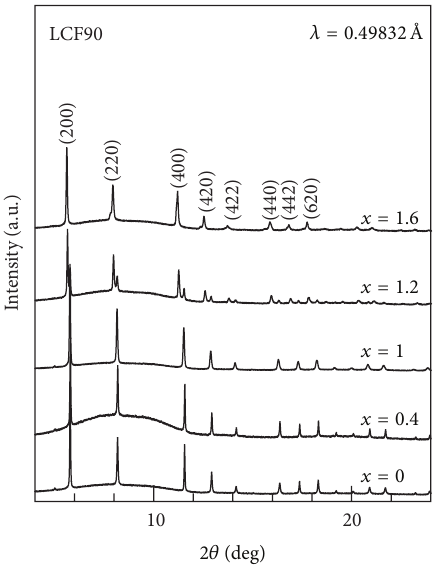
Figure 10: XRD pattern of powered LCF90 against 𝑥 . Values in parentheses represent indexes in the face-centered cubic setting (cited from